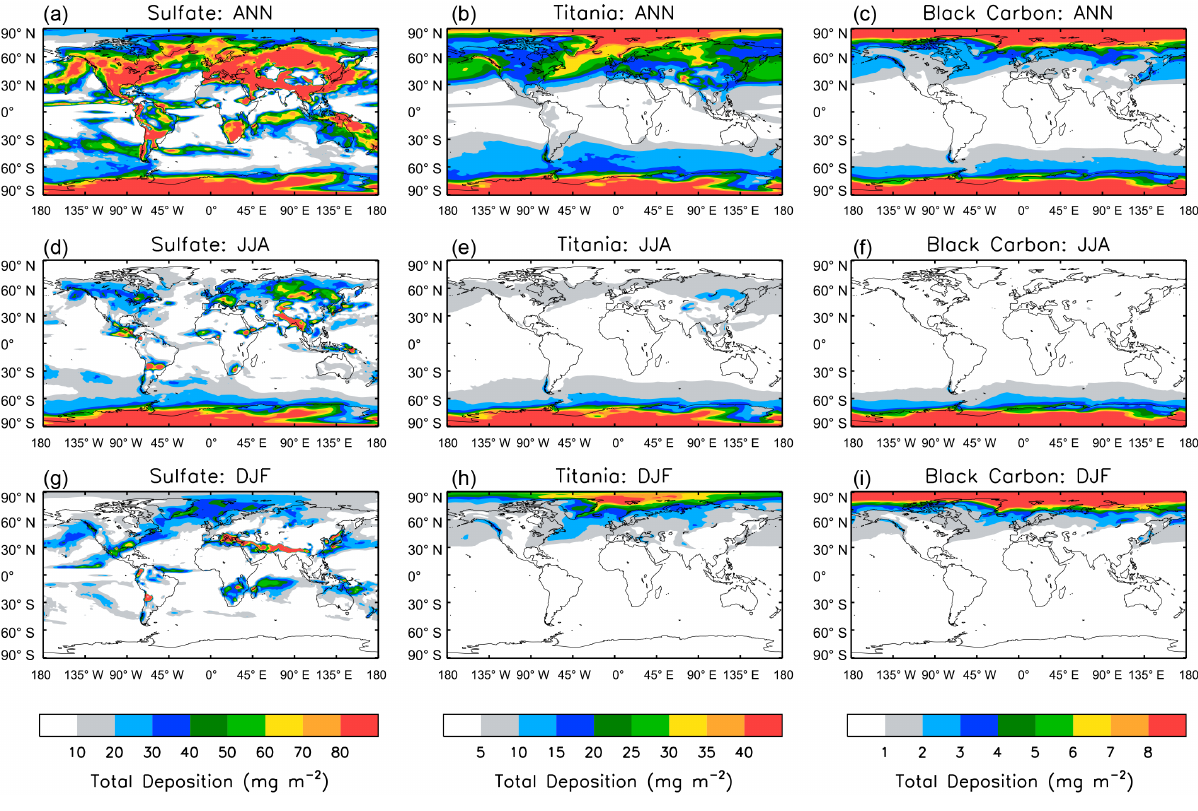
Figure 5. Annual and seasonal total deposition anomalies (in units of mgm − 2 yr − 1 and 0.25 × mgm − 2 yr − 1 ,